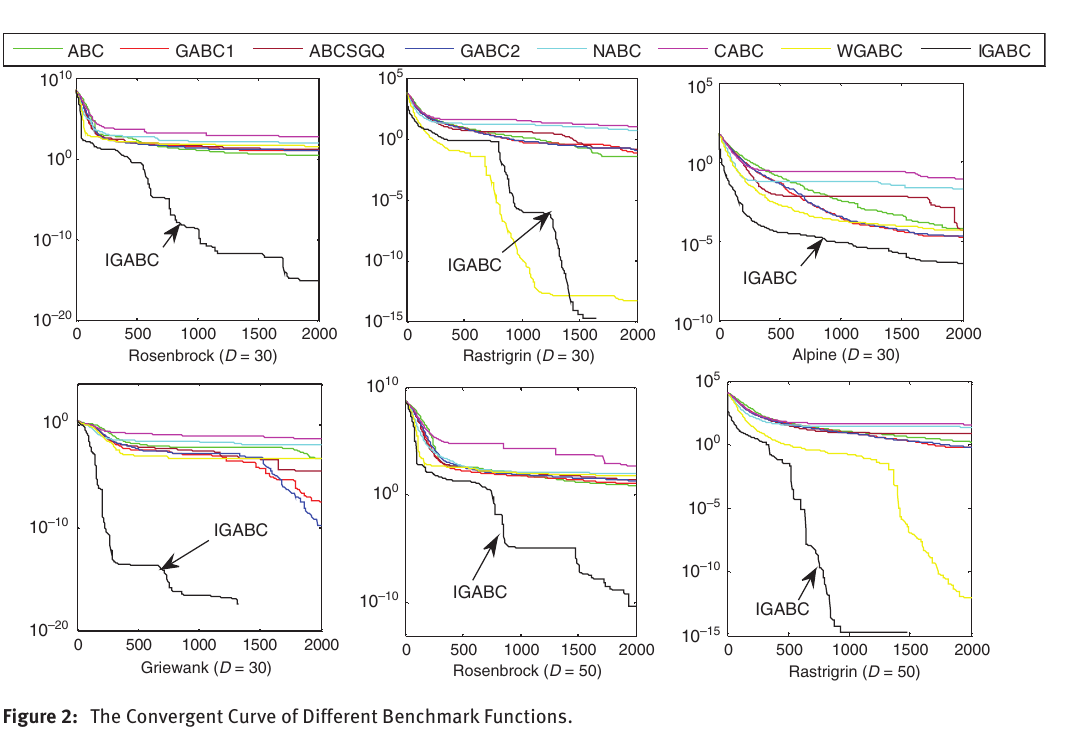
Figure 2: The Convergent Curve of Different Benchmark Functions.